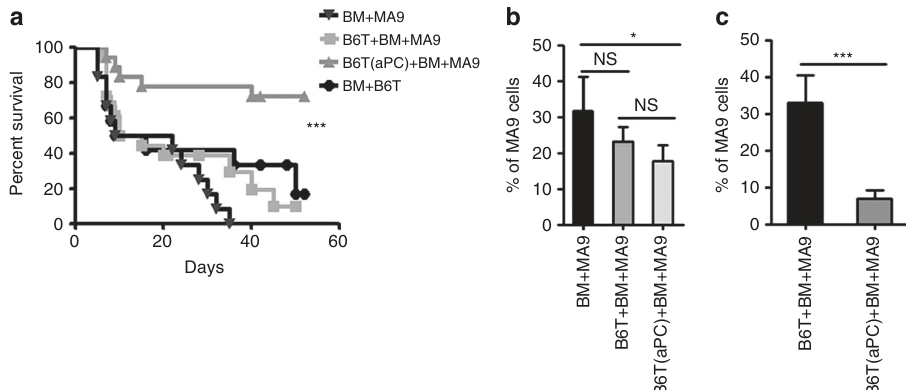
Fig. 10 aPC-preincubation of mouse pan T-cells does not impair GvL effect. a , b Lethally irradiated (11 Gy)-recipient BALB/c mice were transplanted with 5 × 10 6 C57BL/6-derived BM cells, 5×10 3 GFP + MLL-AF9 (MA9) leukaemic cells, and 0.5 × 10 6 C57BL/6 T-cells without (B6T + BM + MA9) or with (B6T(aPC)+ BM + MA9) aPC-preincubation. These groups were compared with the BALB/c mice receiving only allogenic BM and T-cells (B6T + BM) or receiving only allogenic BM and MA9 leukaemic cells (BM + MA9). In mice transplanted with aPC-preincubated T-cells and MA9 leukaemic cells (B6T(aPC)+ BM + MA9) survival is improved ( a Kaplan – Meier curve) and leukaemic load (determined by fl ow cytometry 1 week ( b ) and 4 weeks ( c ) after transplantation in peripheral blood samples) is markedly decreased; pooled data from three independent experiments each with four recipients. Mean value ± SEM; corresponding exemplary FACS images for Fig. 10b, c are shown in Supplementary Fig. 14; * P < 0.05; *** P < 0.001, NS non signi fi cant ( a log-rank test; b , c t